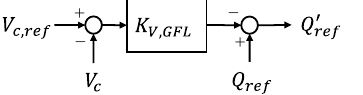
Figure 8. Voltage controller for VI-GFL.